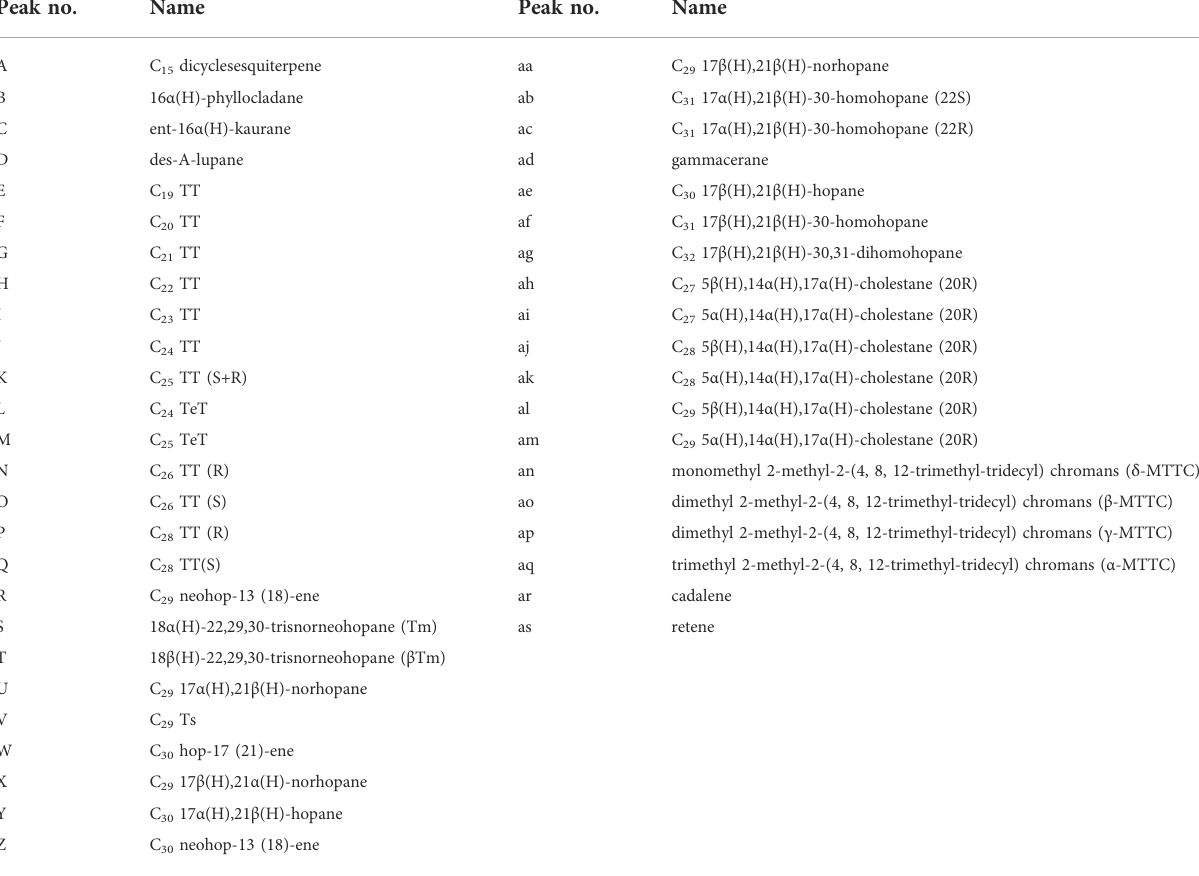
TABLE 1 Abbreviations for the assigned biomarker compounds in Figure 4. Peak no. Name Peak